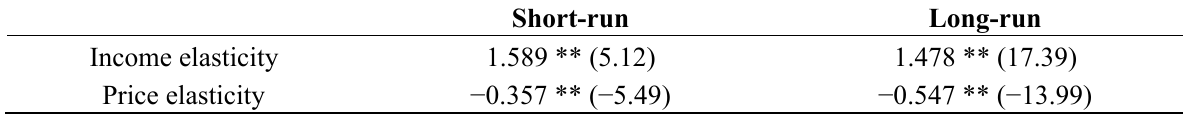
Table 6. Estimated results of the elasticities of diesel